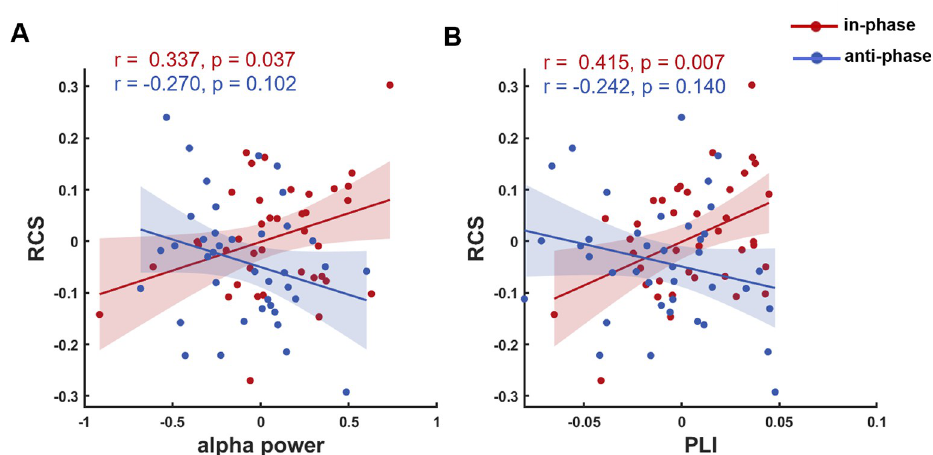
Fig 5. Relationships between tACS-induced changes in RCS and EEG metrics in Experiment 1. The in-phase tACS- induced changes in RCS were positively correlated with ( A ) the changes in alpha power, and ( B ) the changes in PLI; no correlation was found for anti-phase tACS. The RCS, alpha power, and PLI values are given relative to the Baseline values (i.e., after subtracting corresponding Baseline values). The underlying data supporting Fig 5 can be found in the Supporting information as S1 Data. EEG, electroencephalogram; PLI, phase lag index; RCS, rate correct score; tACS, transcranial alternating current stimulation.